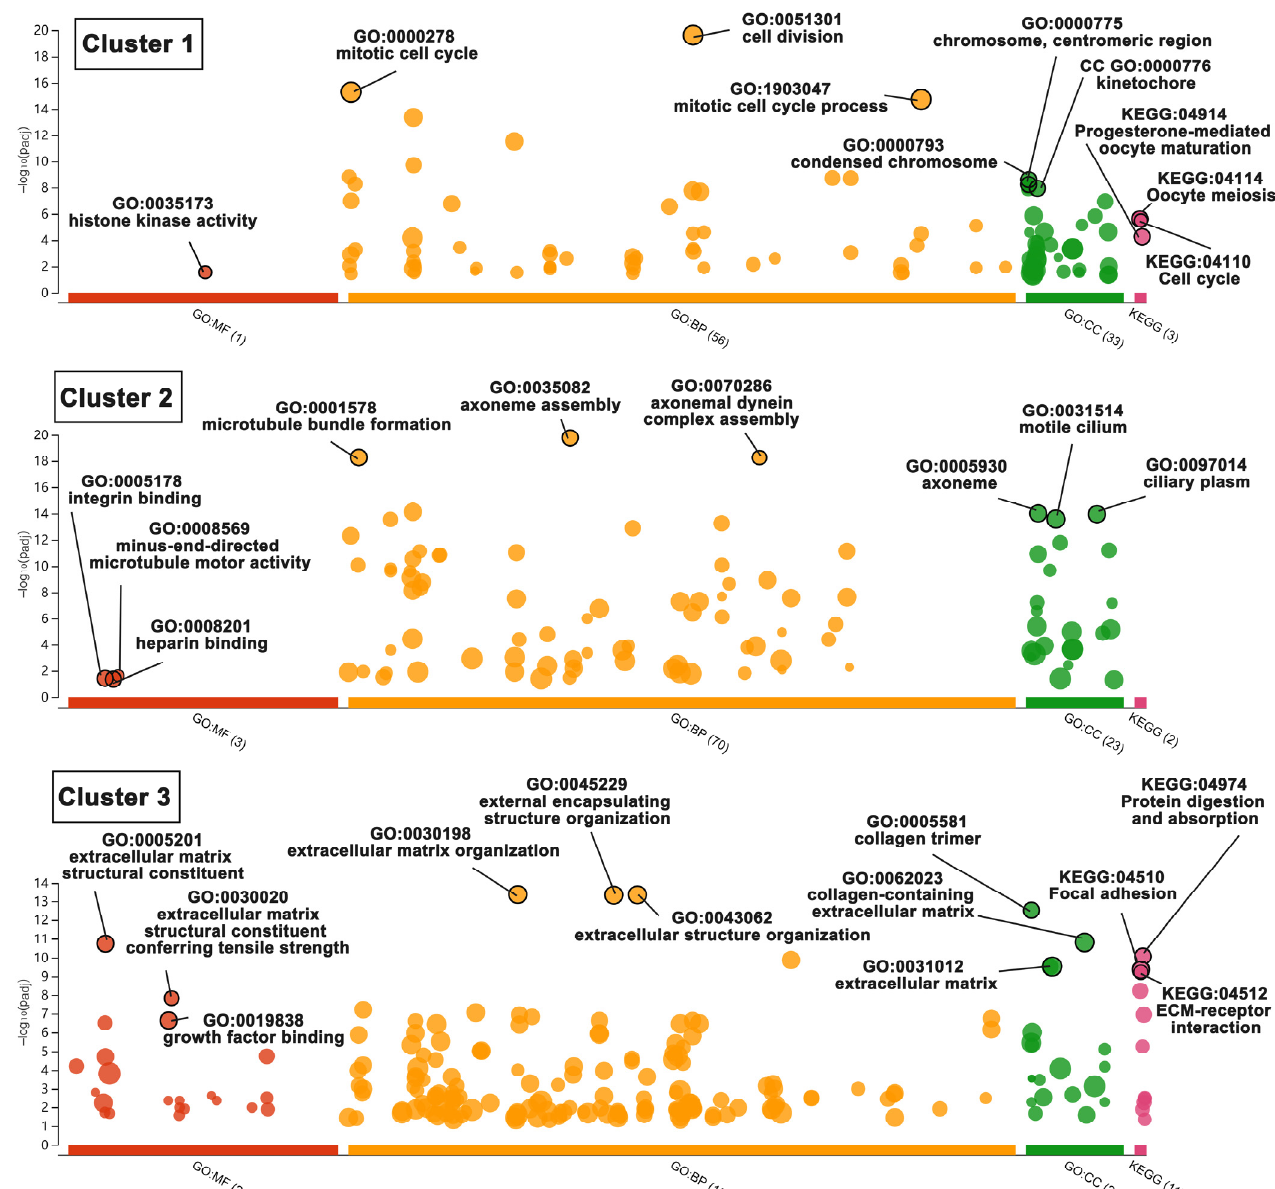
Figure 8. Bubble plot of enriched BP, CC, MF GO terms and KEGG pathways in sub-cluster 1, 2, and 3. Bubble size represents term size. In the vertical direction, the higher the bubble, the more significantly enriched. In the horizontal direction, colour stands for the categories of terms, and distance between bubbles indicates the similarity. Terms from the same subtree stay close to each other.